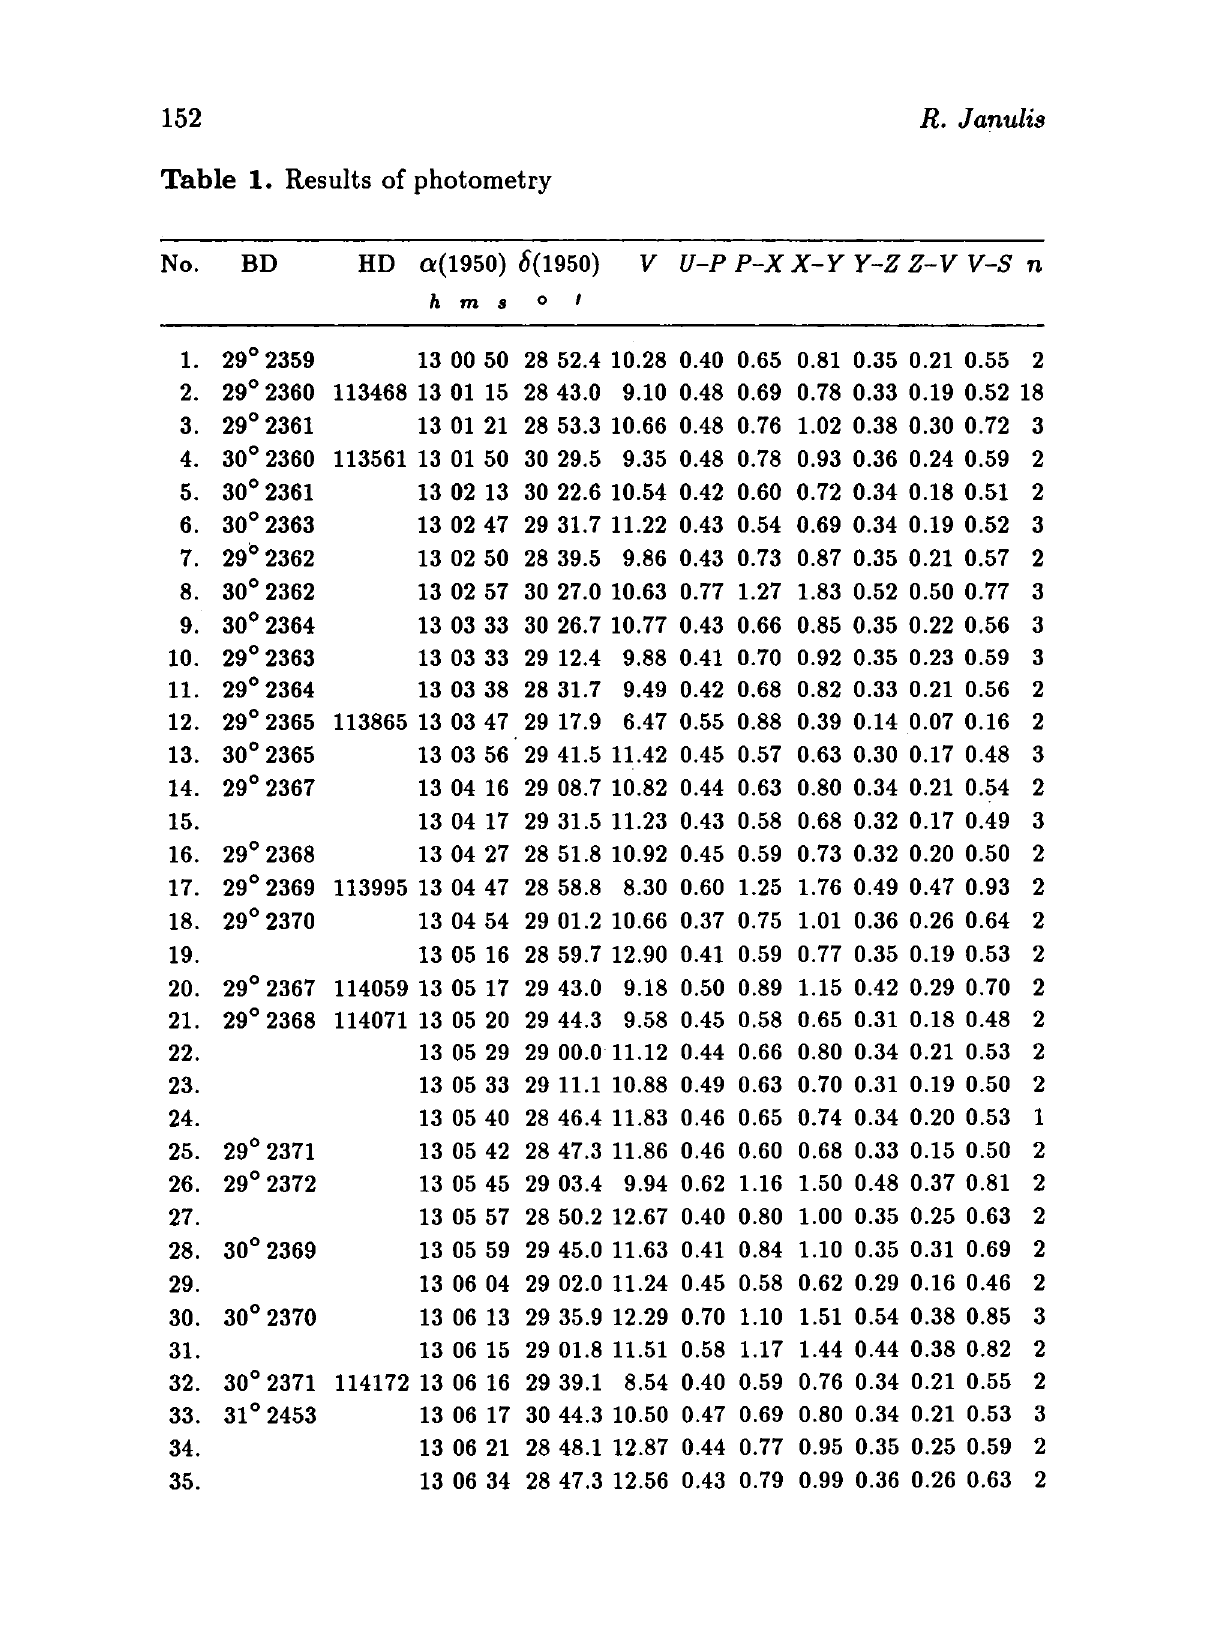
Table 1. Results of